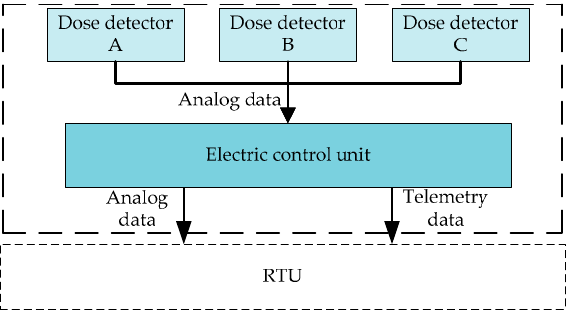
Figure 1. The composition block diagram of the radiation dose